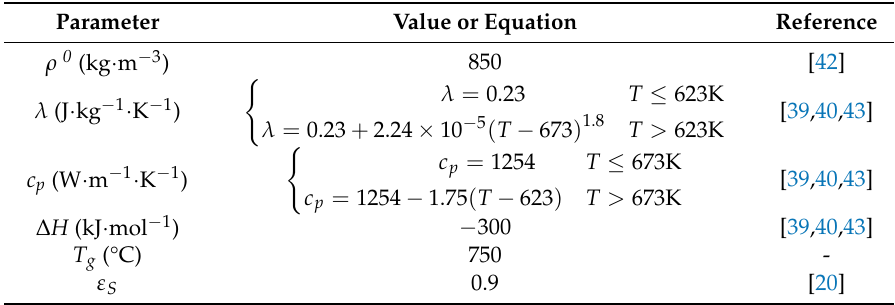
Table 2. Parameters used in the model.